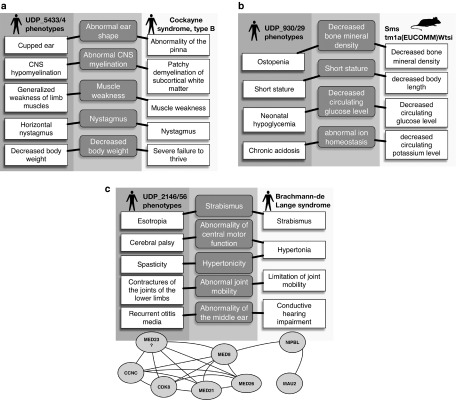
Semantic phenotype matching. For each variant that passed the frequency and Mendelian inheritance filters, the patient's Human Phenotype Ontology terms were compared to all human diseases associated with the gene containing the variant in OMIM or Orphanet, (a) as well as any phenotypes associated with orthologs of the gene in mice or zebrafish (b). If there was no phenotypic match between the patient and any phenotypes associated with the gene, then the patient's phenotype was compared with phenotypes associated with nearby genes in the protein–protein association network (c). When calculating the phenotypic score, the network considered the similarity to the patient phenotype and proximity of the matching gene to the gene in which the patient had a mutation.